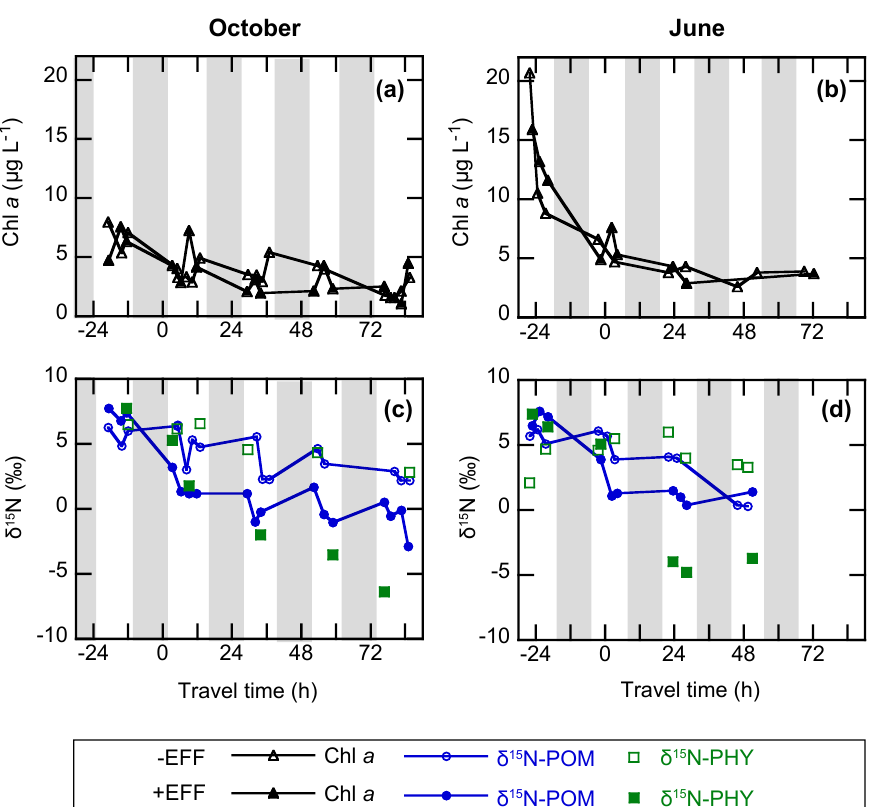
Figure 3. Comparison of Chl a , δ 15 N-POM, and δ 15 N-PHY in parcels sampled in October (a, c) and June (b, d) for parcels that did receive effluent from the WWTP ( + EFF) and parcels that did not receive effluent ( − EFF). Samples are plotted by travel time, where zero indicates the time the parcel passed the location where effluent high in NH + enters the river. Shaded areas indicate 4